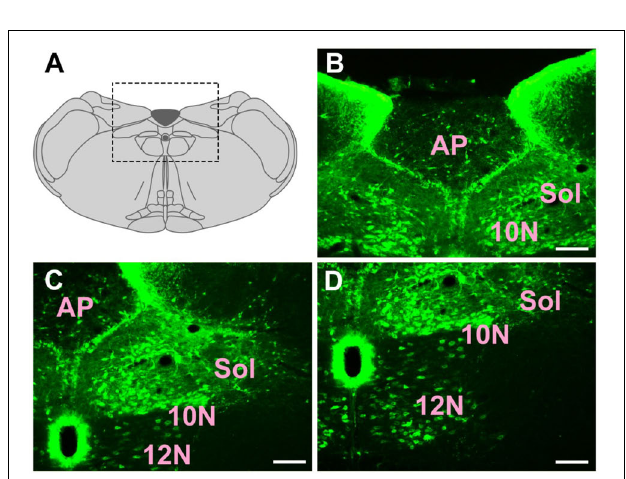
FIGURE 8 | The distribution of neurons labeled by CB in the medulla oblongata Part III (A–D) . 10N, dorsal motor nucleus of vagus; 12N, hypoglossal nucleus; Sol, solitary nucleus; AP, area postrema. Scale bar = 100 µ